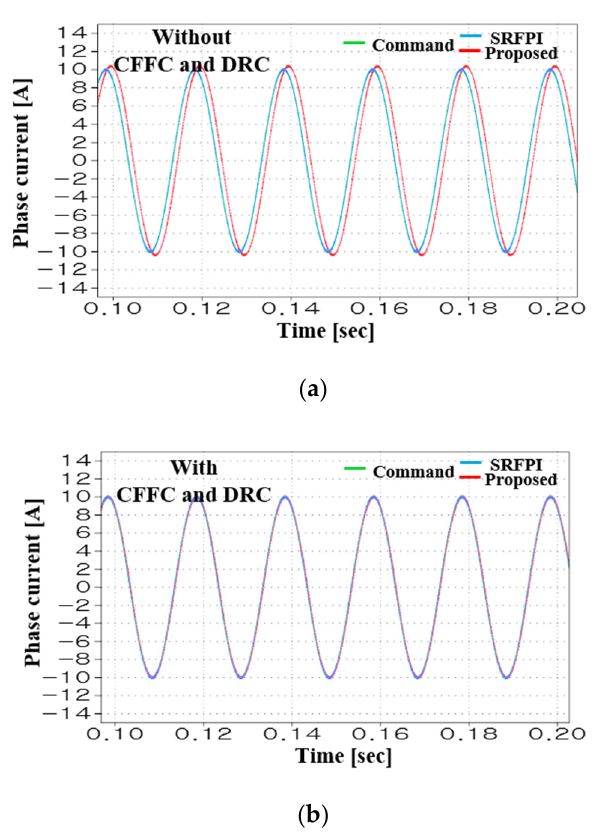
Figure 7. Simulation results of GCI current control system for the proposed stationary reference frame proportional-integral (PI) current control and synchronous reference PI (SRFPI) current control ( a ) without and ( b ) with the CFFC and DRC.